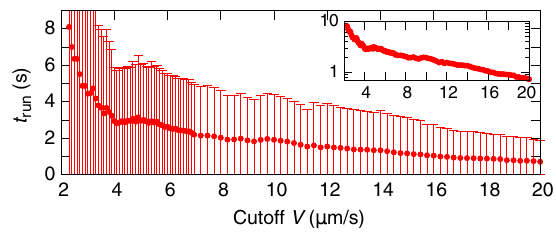
FIG. 8. Average run duration as a function of the threshold in bacterial velocity (cutoff V ). The runs are identified as continuous parts of the track where V > cutoff V . The plot demonstrates that an arbitrary choice of velocity drops along the trajectory leads to arbitrary run-time duration. Inset: Log-normal